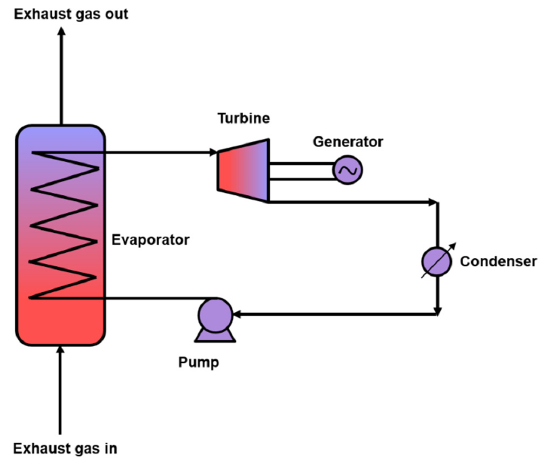
Figure 6. Schematic diagram of a simple organic Rankine cycle.